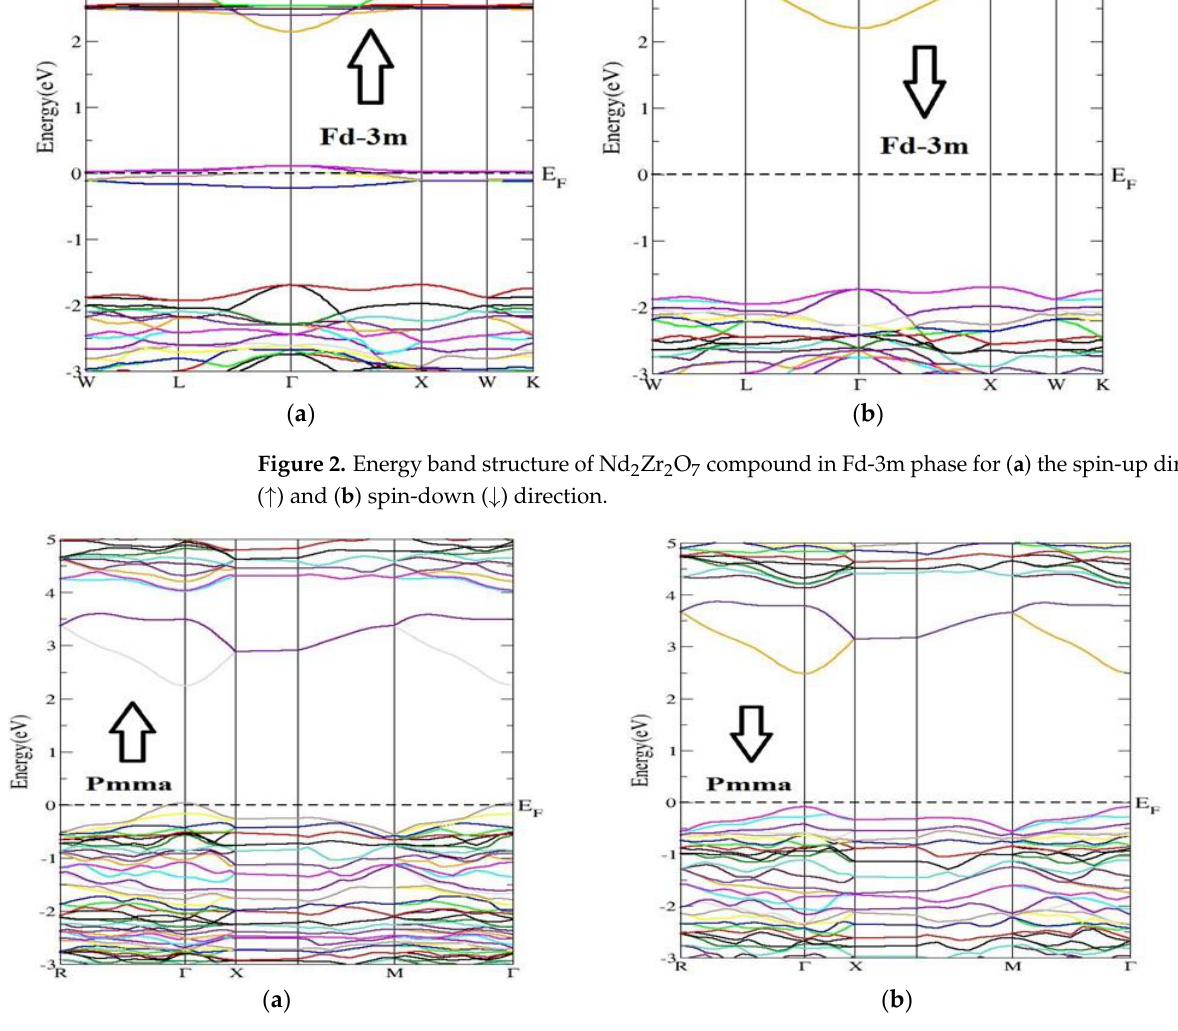
Figure 3. Energy band structure of the Nd 2 Zr 2 O 7 compound in the Pmma phase for the ( a ) the spin-up direction ( ↑ ) and ( b ) spin-down ( ↓ ) direction. spin-up direction ( ↑ ) and ( b ) spin-down ( ↓ )